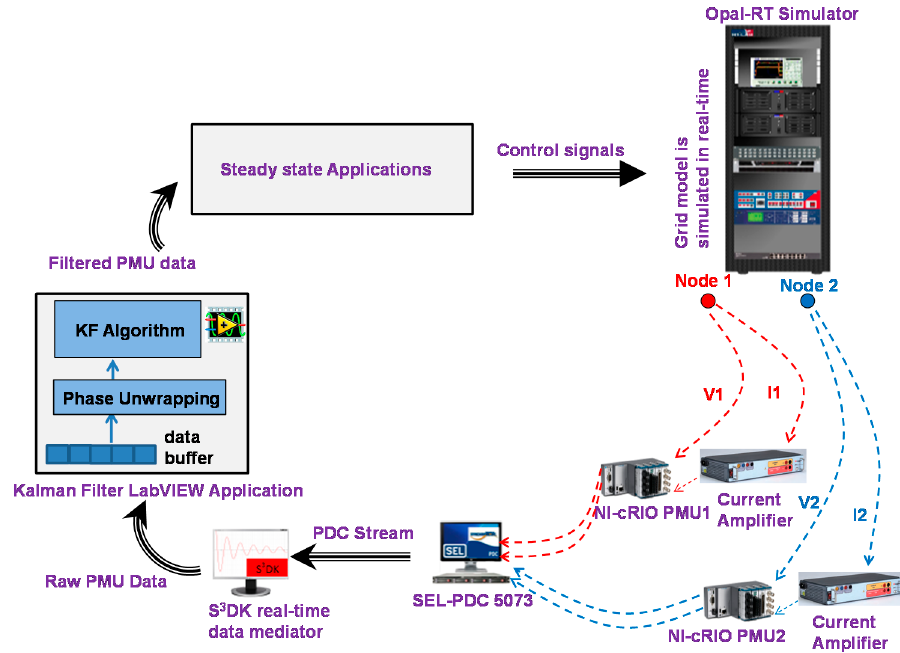
Figure 5. Hardware ‐ in ‐ the ‐ Loop (HIL) Lab Setup. Figure 5. Hardware-in-the-Loop (HIL) Lab